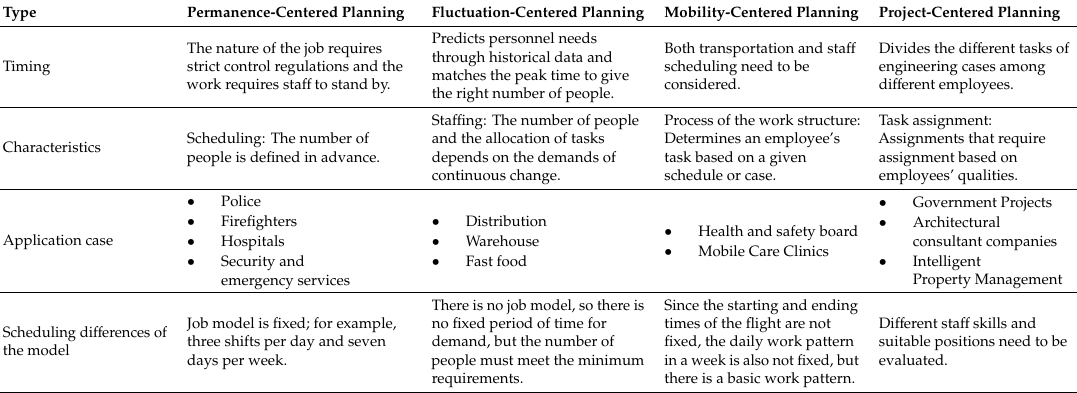
Table 1. Comparison Chart of scheduling problem classifications.